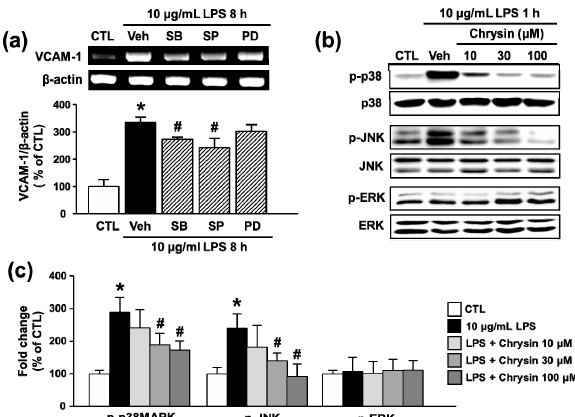
Figure 4. Effect of MAPK on LPS-induced VCAM-1 expression and of chrysin on p38 and JNK activation in bEnd.3 cells. ( a ) Cells were pretreated with SB202190 (SB, 10 μ M), SP600125 (SP, 10 μ M), and PD98059 (PD, 10 μ M) for 30 min and then co-stimulated with LPS (10 μ M) for 8 h. The levels of VCAM-1 mRNA were evaluated by RT-PCR and quantified by densitometry; and ( b , c ) cells were pretreated with chrysin (10–100 μ M) for 30 min and then co-stimulated with LPS (10 μ g/mL) for 1 h. Whole cell extracts were prepared and analyzed by Western blot with anti-phospho p38, anti-phospho JNK, p38 MAPK antibody, or JNK antibody. * p < 0.05 vs. control and # p < 0.05 vs. vehicle, n = 3. To provide possibility of the therapeutic effects of chrysin in an established disease condition, we examined the protective potential of chrysin through the co-treatment and 4 h post-treatment of chrysin with 10 μ g/mL LPS in bEnd.3 cells. Co-treatment with chrysin inhibited the mRNA expression of VCAM-1 in LPS-induced bEnd.3 cells in a concentration-dependent manner, but not ICAM-1 and E-selectin (Figure 5a,b). Similarly to the results of co-treatment with chrysin and LPS, 4 h post-treatment with chrysin also inhibited only VCAM-1 expression (Figure 5c,d). These findings indicate that chrysin plays an anti-inflammatory role by arresting the progression of LPS-induced inflammation during disease conditions.